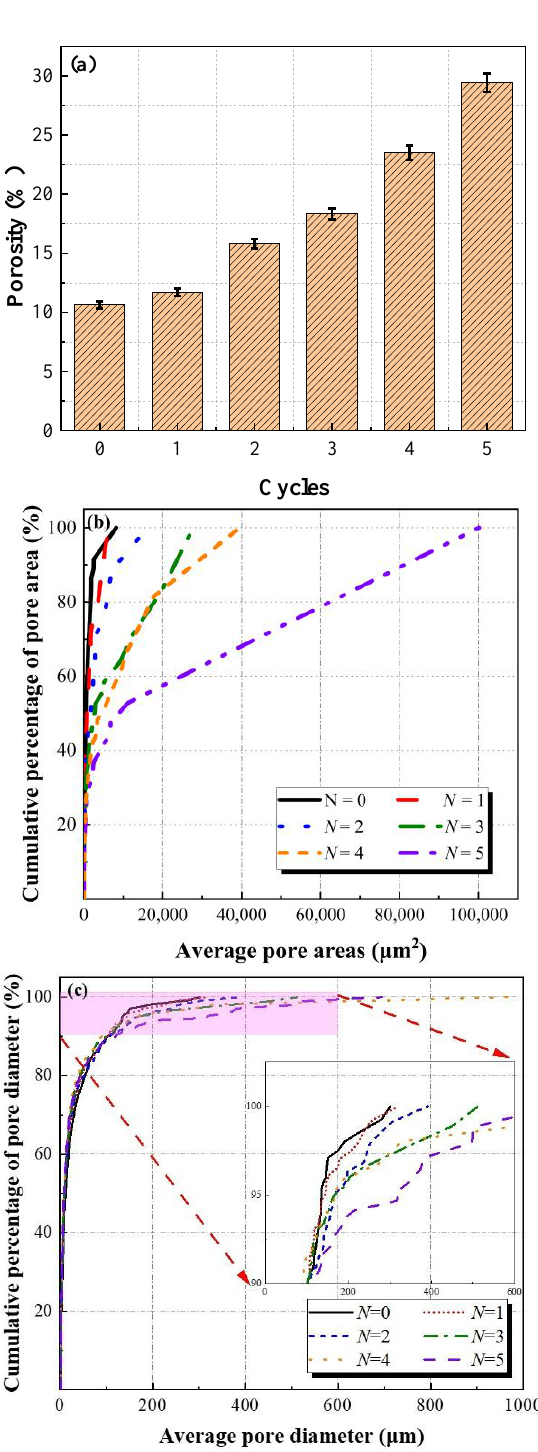
Figure 8. Image processing of specimens at different wet-dry cycles.